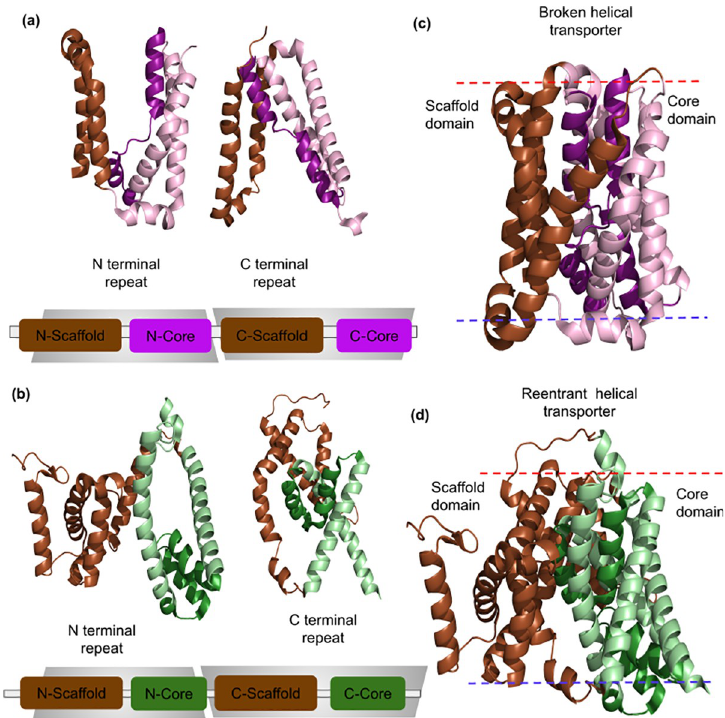
Fig 1. General structure of CPA/AT transporters. (a) Example of broken helical transporter (Sodium bile acid symporter: PDB 4n7w) shown as N- and C-terminal repeat. Each repeat unit is composed of a scaffold and a core subdomain. (b) Example of reentrant helical transporter (Sodium citrate symporter: PDB 5a1s) shown as N- and C- terminal repeat. (c) In structure space, both the N- and C-terminal subdomains form the scaffold and core domains, respectively. The lipid bilayer is colored red and blue to denote outside and inside. The scaffold and core domain are colored brown and purple respectively. (d) The scaffold and core domain are colored brown and green respectively. The broken and reentrant helices are shown in darker shades compared to other helices of the core domain for easy visualization.